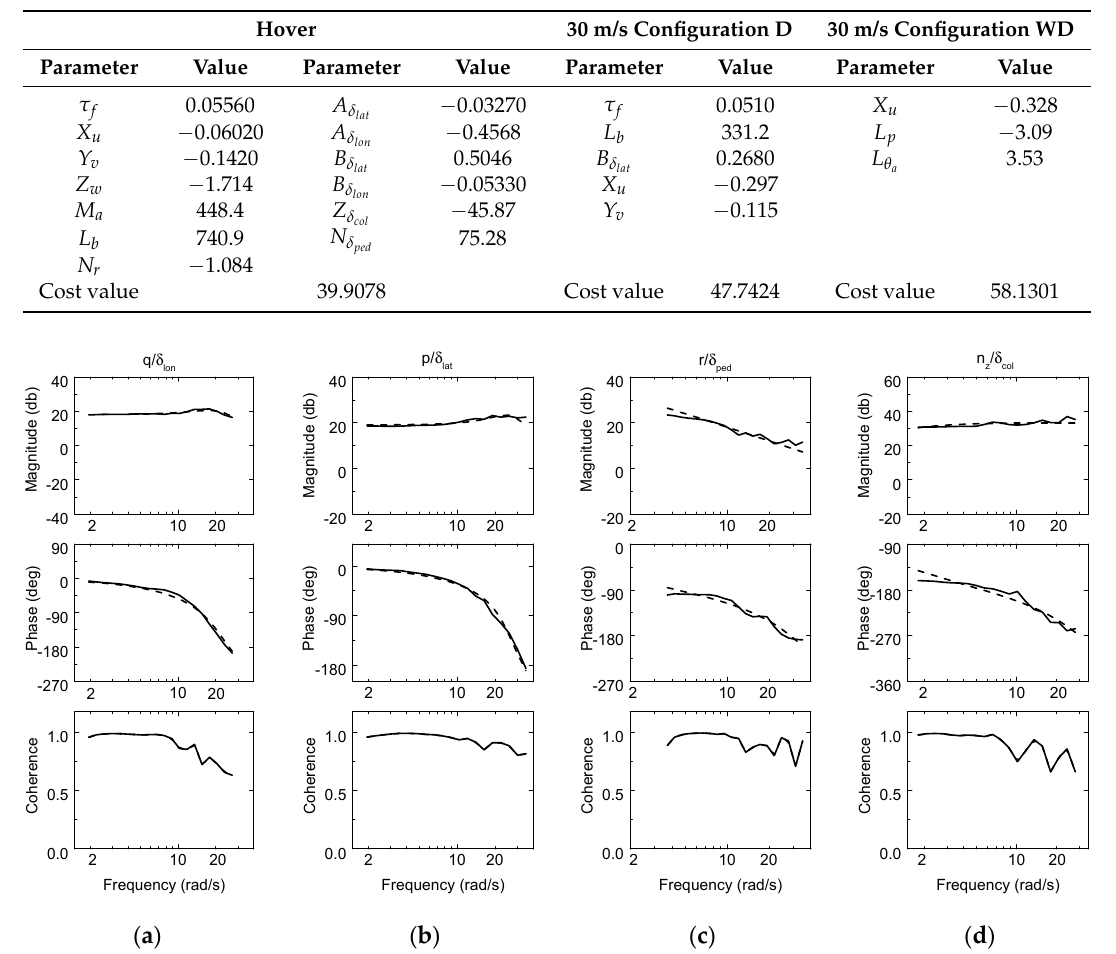
Table 4. Main parameters from linear identification model (IDM).